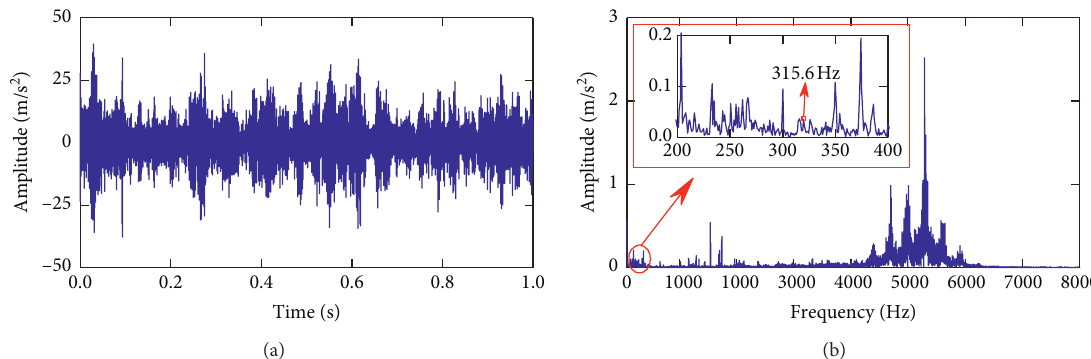
Figure 18: The experimental signal of the wind turbine generator: (a) time-domain spectrum; (b) FFT spectrum.